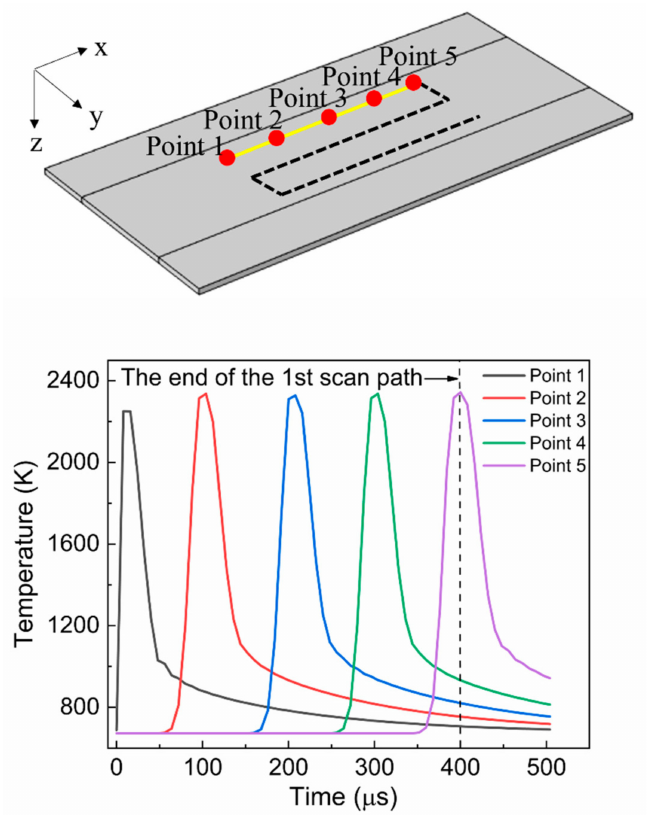
Figure 3. Temporal profile of the temperature obtained at five points over the first scan path.